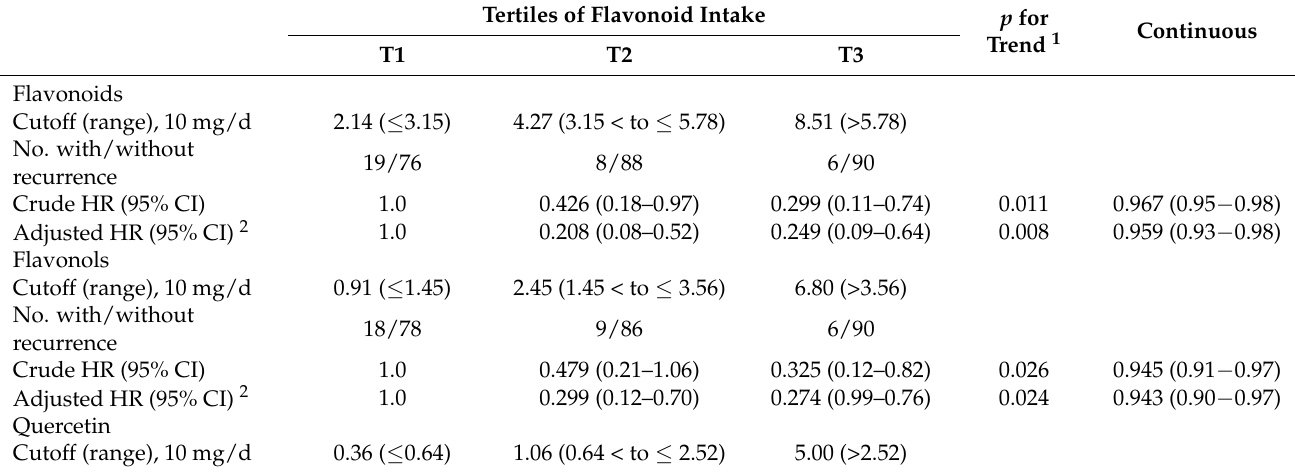
Table 3. Association between dietary intake of flavonoids and cancer recurrence in overweight and obese